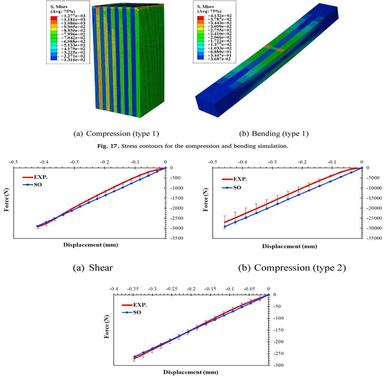
Comparisons with results of the inverse identification analysis (Class 2).